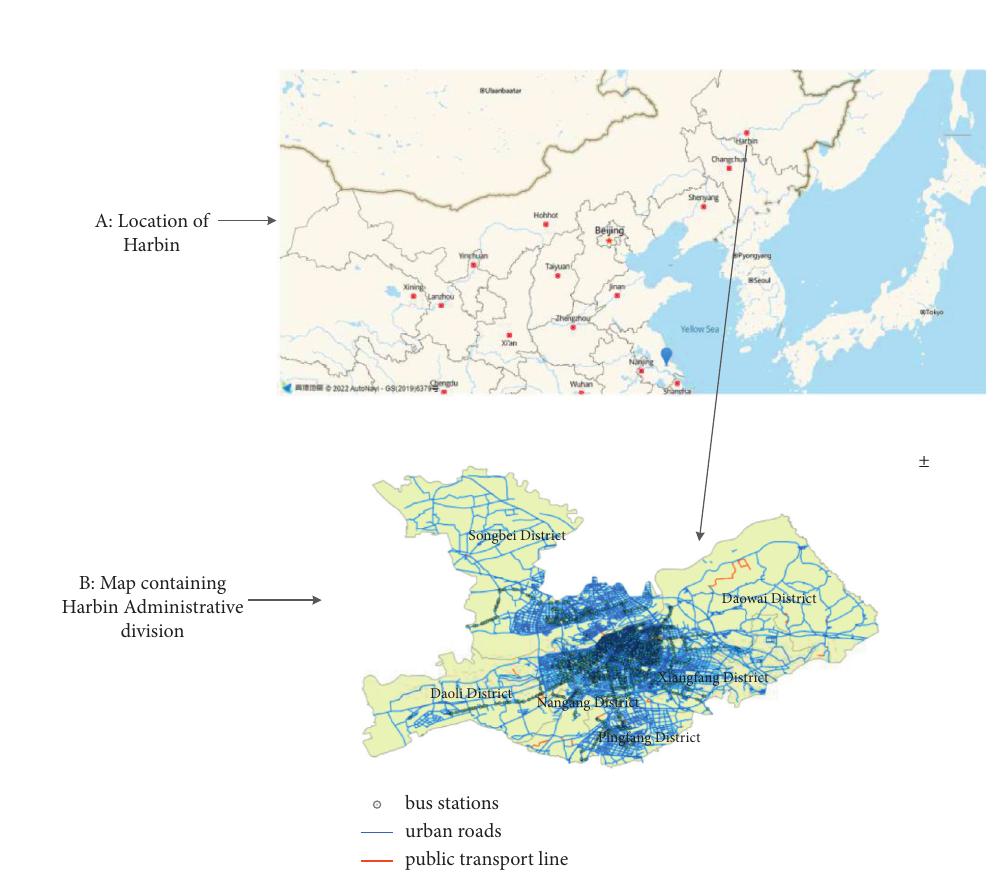
Figure 3: Demonstration of the research